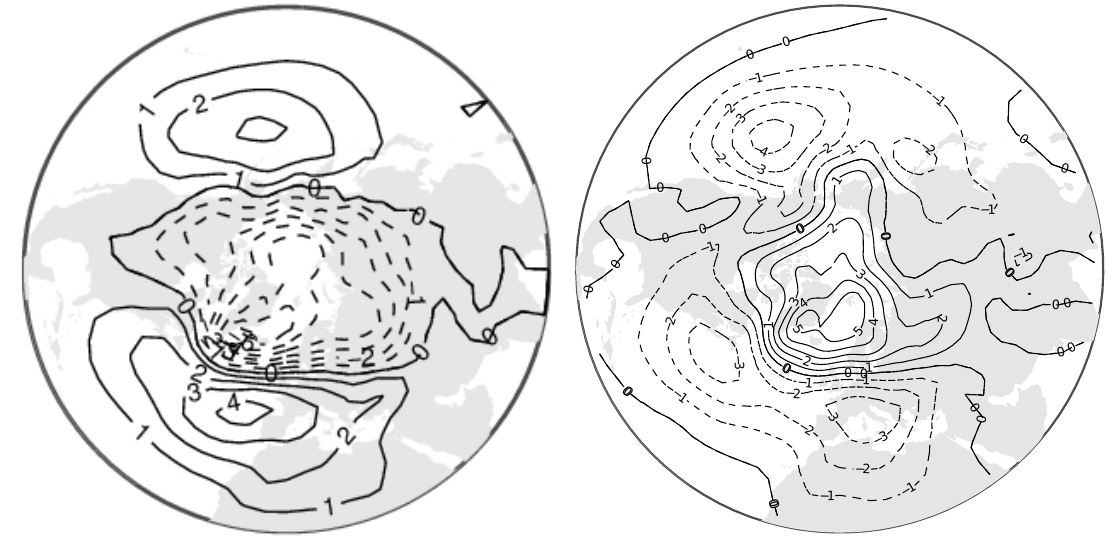
Fig. 7. Left: winter SLP anomaly for a positive NAM index of one standard deviation (hPa). Right: mean winter (DJF) SLP difference (hPa) between a 20 year long simulation with ECHAM4 nudged towards a negative NAM index of one standard deviation and a 20 year long control simulation.